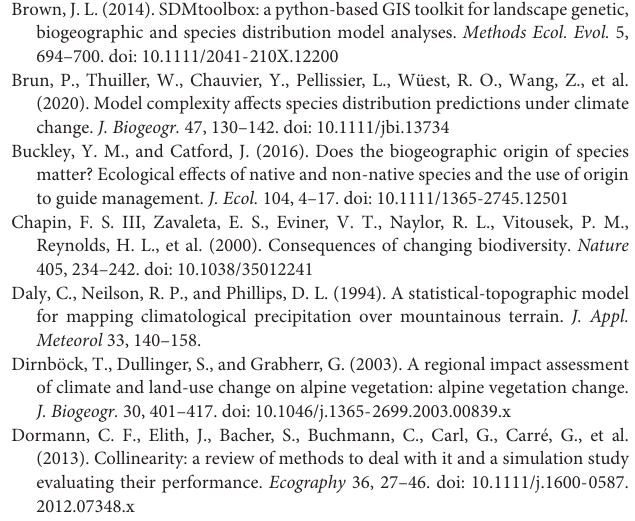
Supplementary Data Sheet 3 |